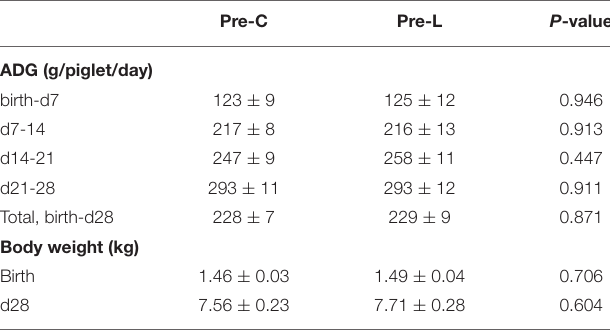
TABLE 5 | Pre-weaning piglet average daily gain and body weight. Pre-C